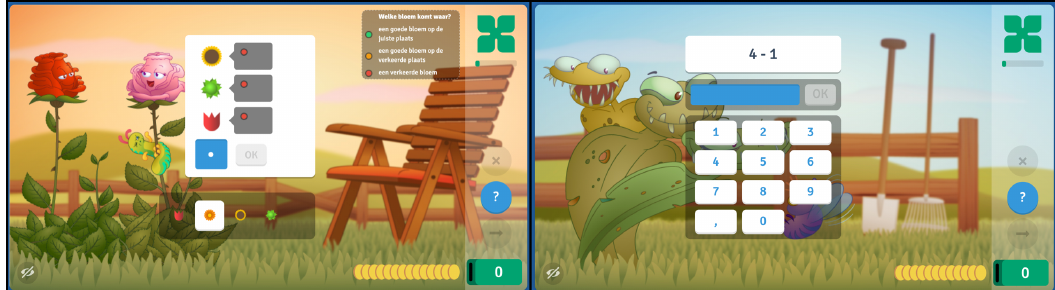
Figure 1. A screenshot of a single item in the Deductive Mastermind game ( left ) and in the Subtraction game ( right ). In the Deductive Mastermind game the coloured circles refer to either a correctly placed flower (green), a correct flower at the wrong location (orange) or a wrong flower (red). For this item the orange flower is the correct